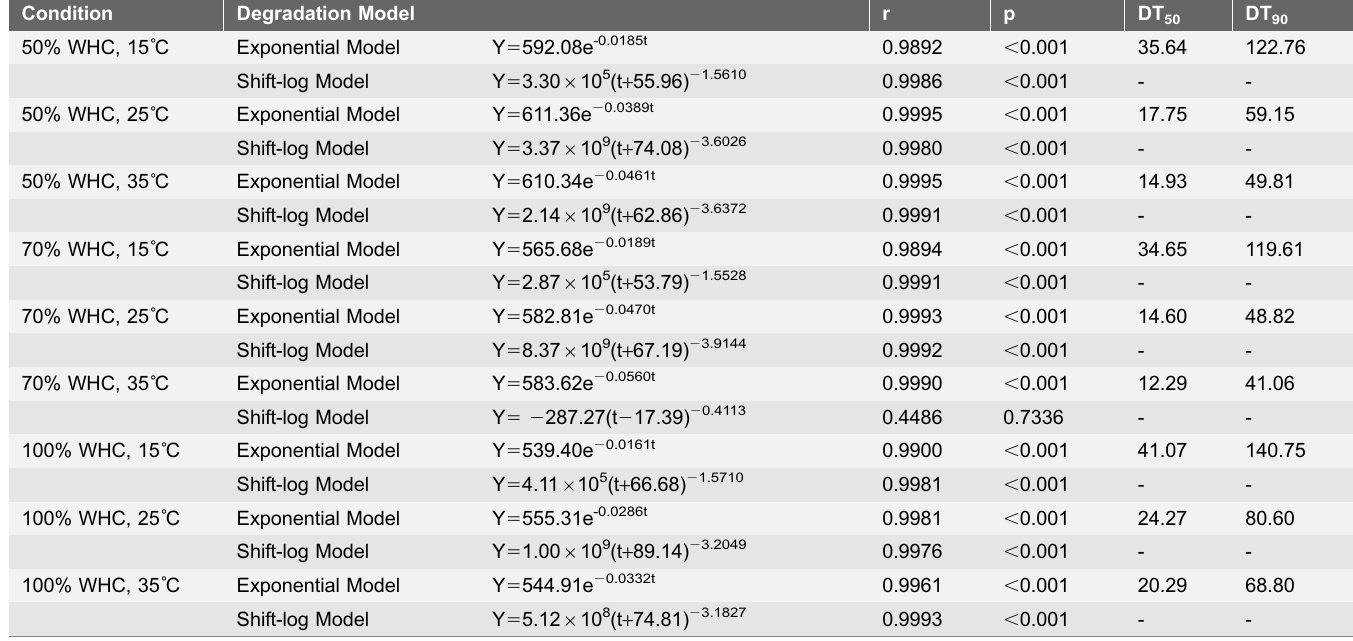
Table 3. Degradation model, DT 50 and DT 90 of Cry1Ac protein in leaves in the soil.